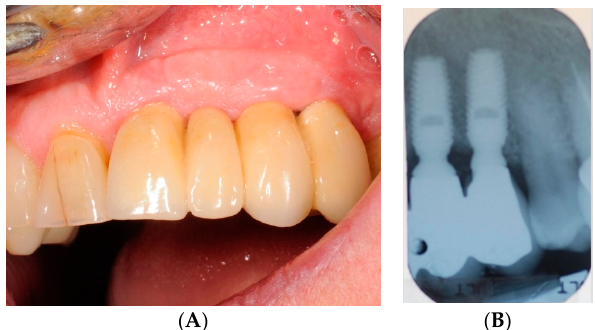
Figure 4. Clinical photograph ( A ) and radiograph ( B ) of a female patient at baseline (T0). The patient presented locking-taper implants in the upper jaw. One implant (site 2.4) affected by mucositis was treated with HBX (Test-Group).